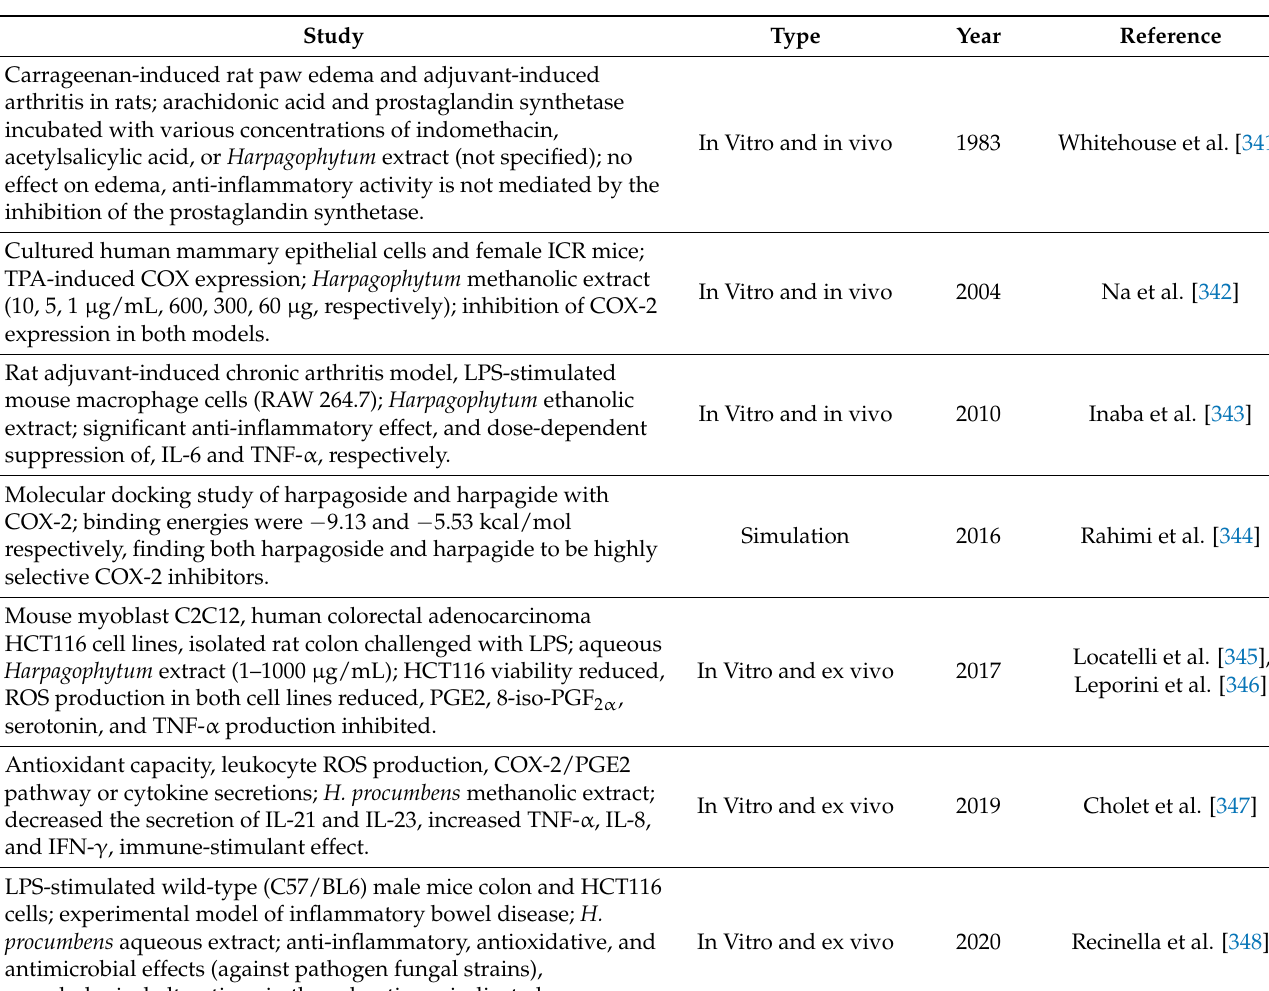
Table 7. Mixed experiments regarding analgesic/antinociceptive and anti-inflammatory effects of devil’s claw preparations and